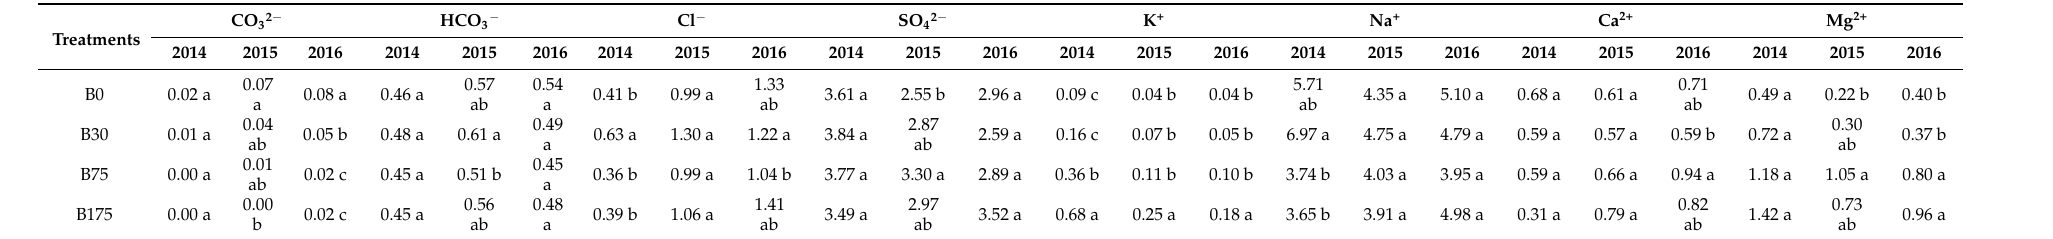
Table 3. Salt ion concentrations in sulfate saline soils amended with biochar at various rates from 2014 to 2016 (cmol kg − 1 ). CO 32 − Treatments